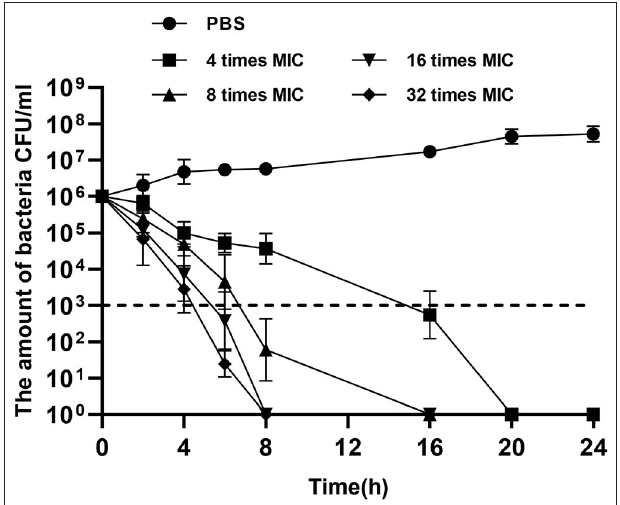
FIGURE 2 | Minimum bactericidal concentrations (MBCs) of phillygenin against H. pylori . between high and low concentrations, as displayed in Figure 3A